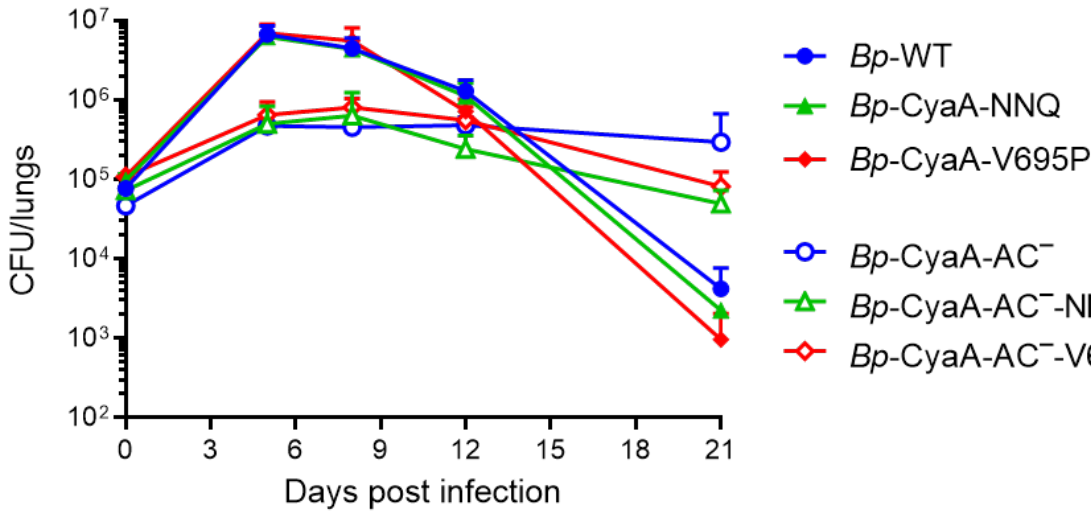
Figure 3. Selective increase of the pore-forming activity of CyaA has no effect on B. pertussis lung colonization. Five-week- old BALB/cByJ mice were challenged intranasally with ~1 × 10 5 CFU of the WT and mutant B. pertussis strains. Each point represents the mean value with SD from 3 to 6 mice. No significant differences in lung colonization were observed at any time point within the group of B. pertussis strains secreting enzymatically active CyaA toxin variants ( Bp -WT, Bp -CyaA-NNQ, and Bp -CyaA-V695P). Similarly, no significant differences in colonization were found within the group of B. pertus- sis strains producing enzymatically inactive CyaA-AC – toxoid variants ( Bp -CyaA-AC − , Bp -CyaA-AC — NNQ, and Bp -CyaA- AC − -V695P). In contrast, significant differences in lung colonization ( p < 0.0001; ANOVA) were observed between B. per-